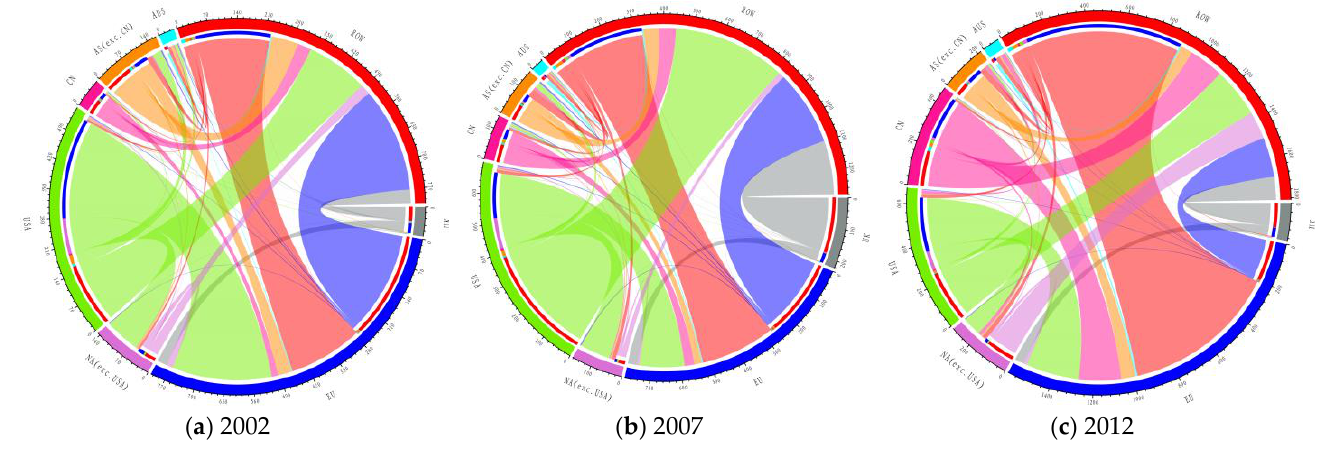
Figure 2. Virtual water flows in 2002 ( a ), 2007 ( b ), and 2012 ( c ).